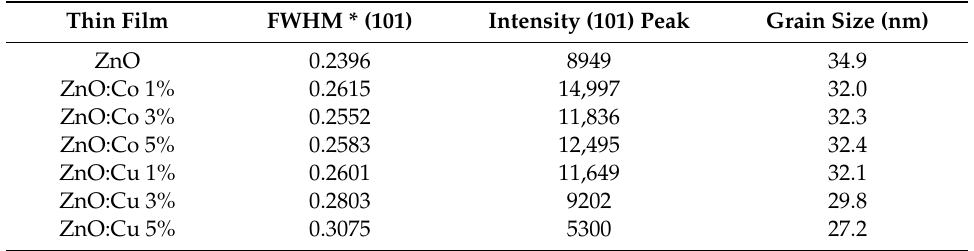
Figure 1. ( a ) X-ray diffraction patterns for the catalysts synthesized in this study. ( b ) Comparison of the highest peak (101) for ZnO:Cu. ( c ) Comparison of the highest peak (101) for ZnO:Co. Table 1. Crystallographic results for the X-ray characterization of both undoped ZnO and metal-doped ZnO thin films.